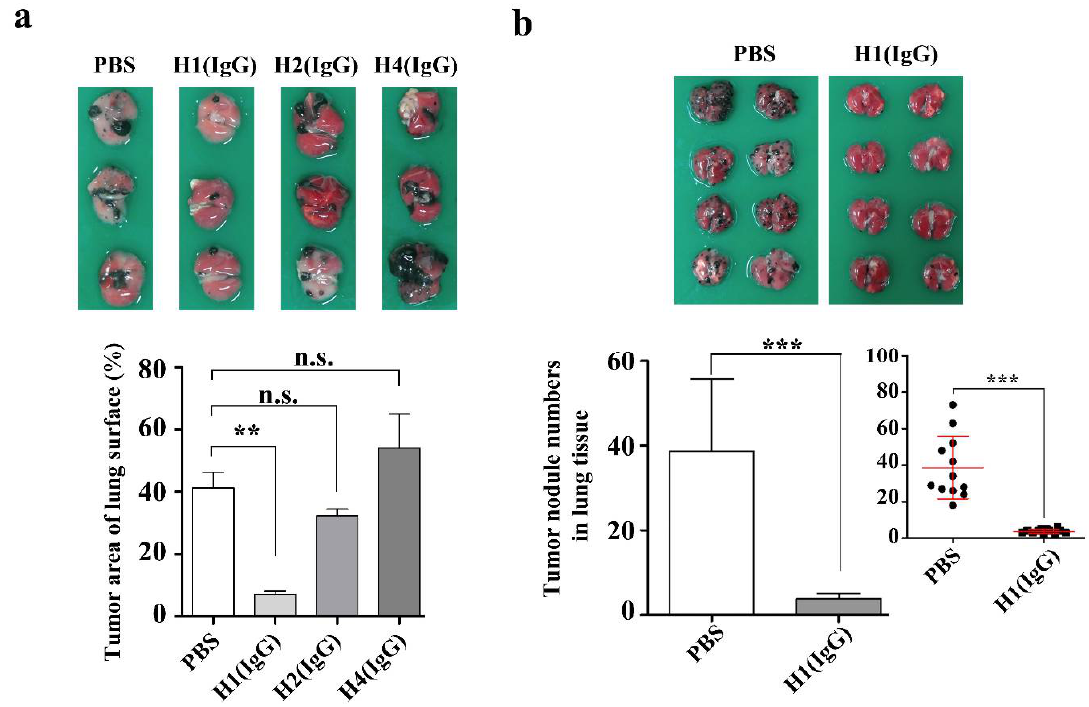
Figure 5. Anti-metastatic effect of anti-hYKL-40 IgGs. ( a ) A plot comparing the inhibitory effects of H1 (IgG), H2 (IgG), and H4 (IgG) by the tumor area on lung tissue. ( b ) A plot revealing the inhibitory effect of H1 (IgG) by the number of tumor nodules on the lung tissue. The original plot, showing the mean value and the standard error of the mean (SEM) marked in red lines, is shown as the inlet. The closed circles indicate the individual lung tissues examined. ** p < 0.01, *** p < 0.001. n.s.: not significant.